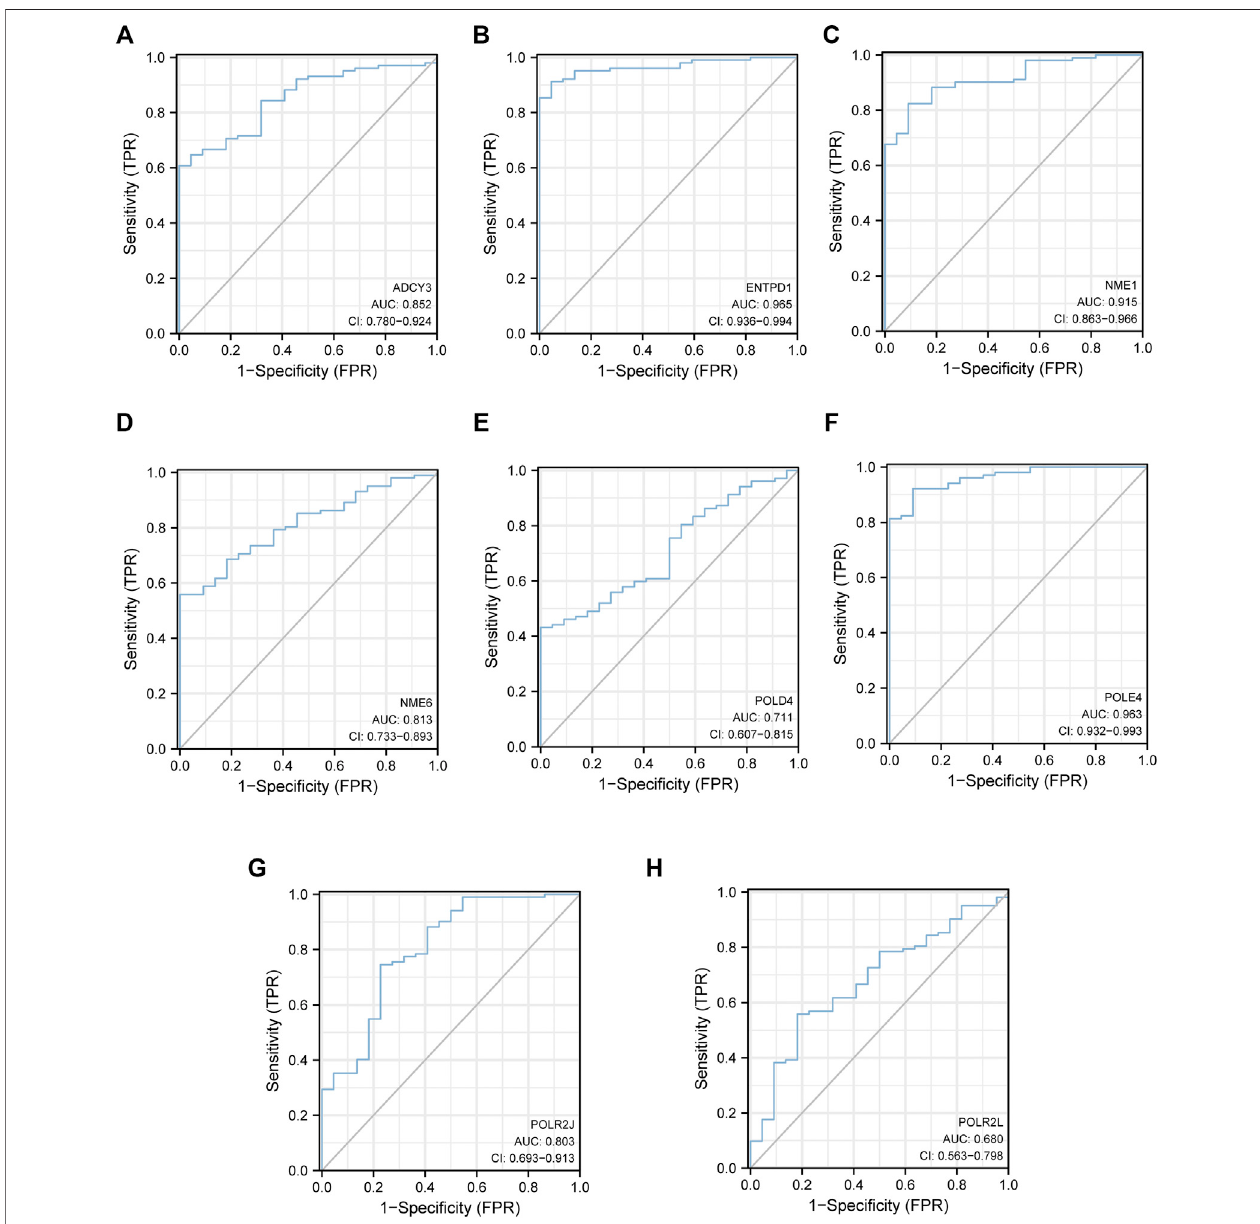
FIGURE 6 | The eight hub genes had potential diagnostic roles in sepsis. (A) ROC of ADCY3 . (B) ENTPD1 . (C) NME1 . (D) NME6 . (E) POLD4 . (F) POLE4 . (G) POLR2J . (H) POLR2L .